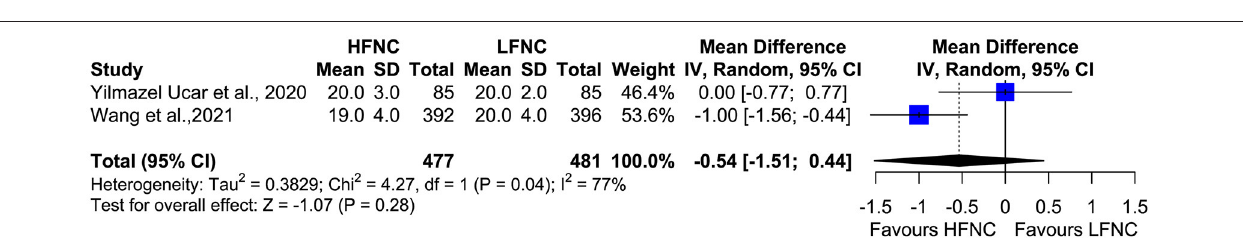
FIGURE 10 | Meta-analysis of RF 10min after the end of procedure in patients receiving HFNC compared to LFNC in patients undergoing bronchoscopic procedures.